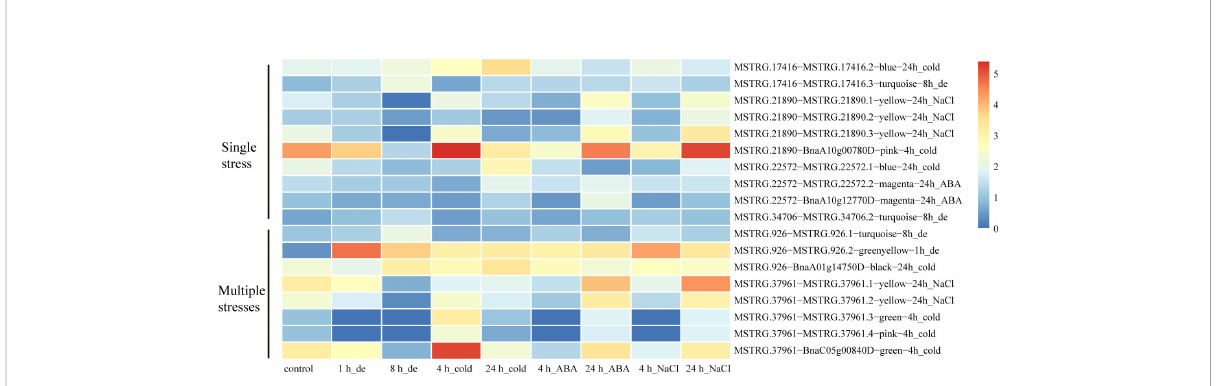
FIGURE 8 Expression heatmaps of each isoform of the candidate DAS genes under single stress or multiple stresses. The texts written behind the isoforms signi fi es their contained co-expression module that related to corresponding